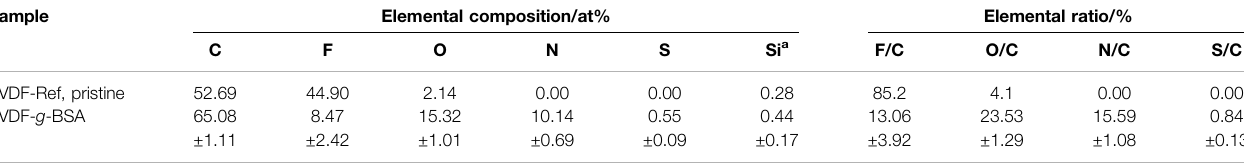
TABLE 7 | XPS measurement data of pristine PVDF reference, and PVDF- graft -BSA modi fi ed via optimized 1-step method ( n (cid:1) 10). Sample Elemental composition/at% Elemental ratio/%